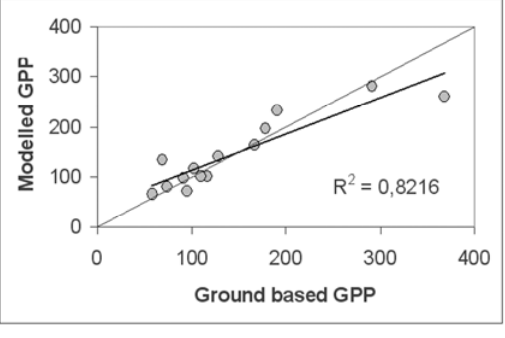
Figure 4. Relationship between the growing seasons GPP modelled in this study and ground-based GPP. Points represent the observed GPP collected at the 14 test sites across the study